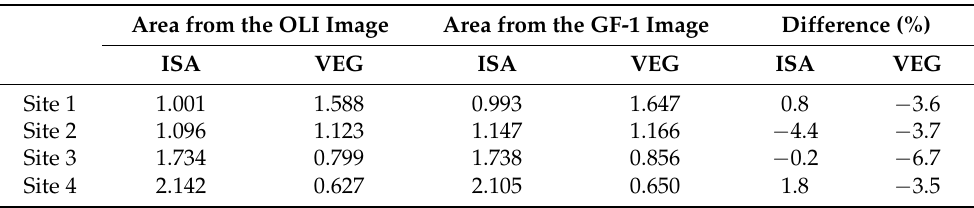
Table 1. Accuracy assessment of the fractional cover of ISA and vegetation (derived by FCLS from a Landsat 8 image acquired on 15 March 2017. Areas measured in km 2